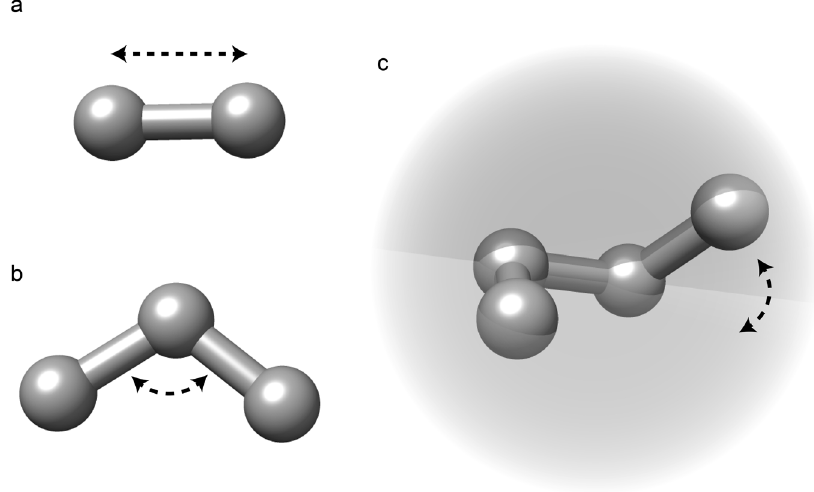
Fig. 9 Representations of various constraints in MD simulations. Graphical representation of the bond ( a ), angle ( b ), and dihedral angle ( c ) constraints in de fi ning a molecule in MD